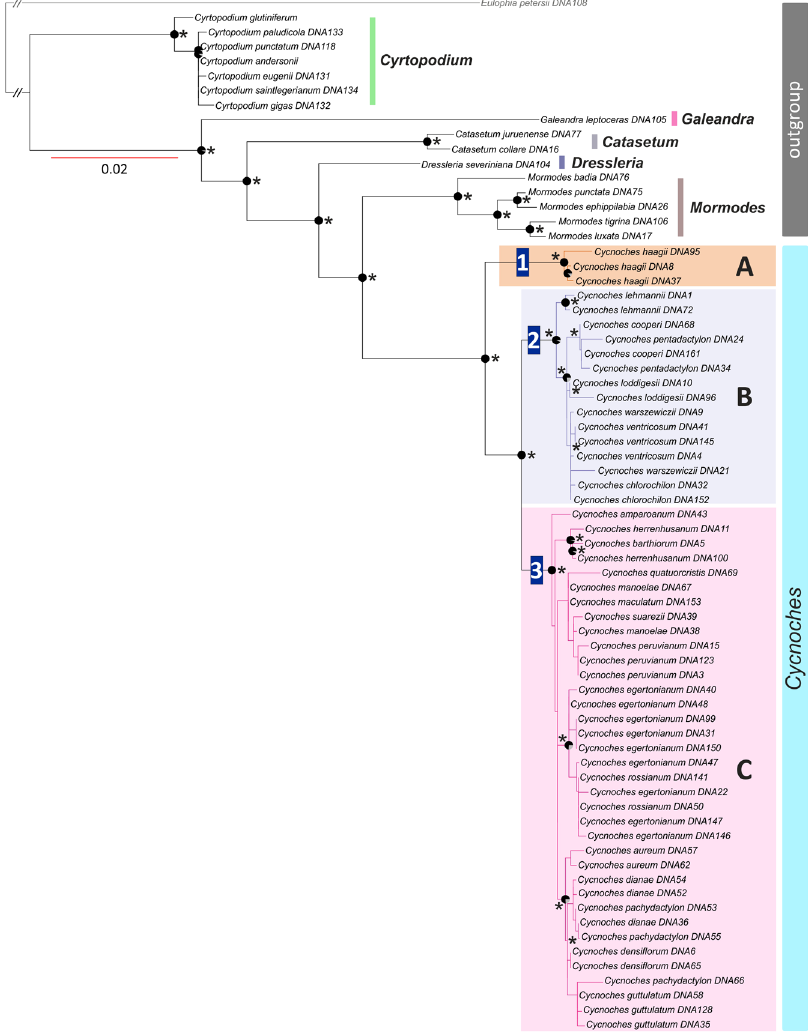
Figure 2. Best scoring ML tree of Cycnoches obtained from concatenated, non-conflicting nuclear ETS, ITS, Xdh and plastid trn S– trn G, ycf 1. Node charts indicate Bootstrap Support (MLBS > 75), in where fully red diagrams indicate MLBS of 100. Numbers at nodes indicate Bayesian Posterior Probability (PP > 0.95).